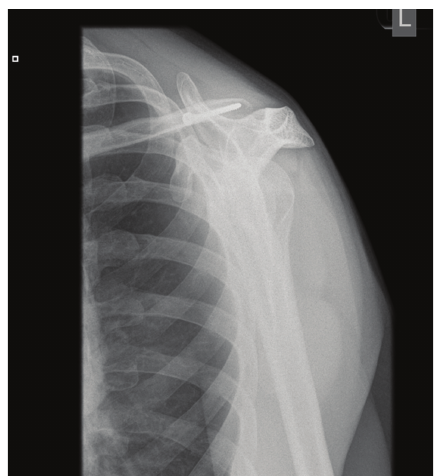
Figure 10: Postoperative Y view radiograph showing the reduced joint with screw in